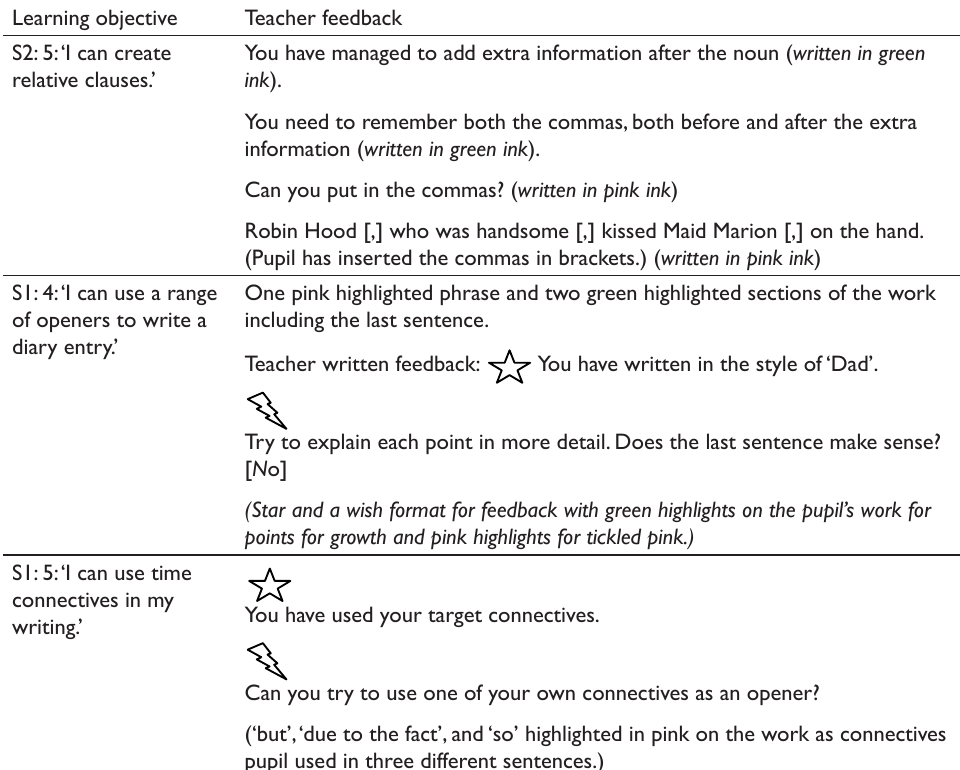
Table 3: Examples of written teacher feedback Learning